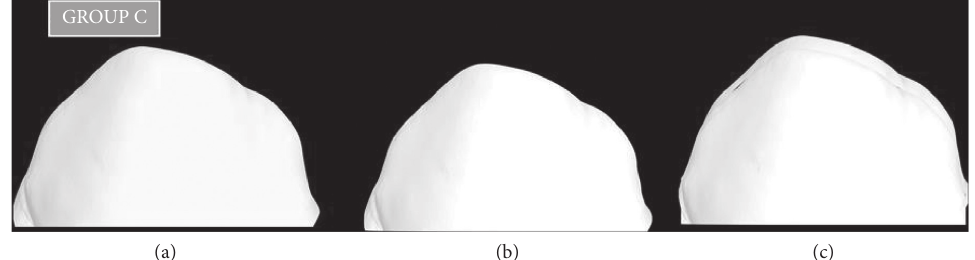
Figure 4: (a) 3D prescan of primary teeth with Group C, (b) 3D postscan of primary teeth with Group C, and (c) superimpose of prescan and postscan with Group C. Table 1: Microhardness of glass-fiber-reinforced composite crowns, zirconia discs, and natural teeth. Sample type